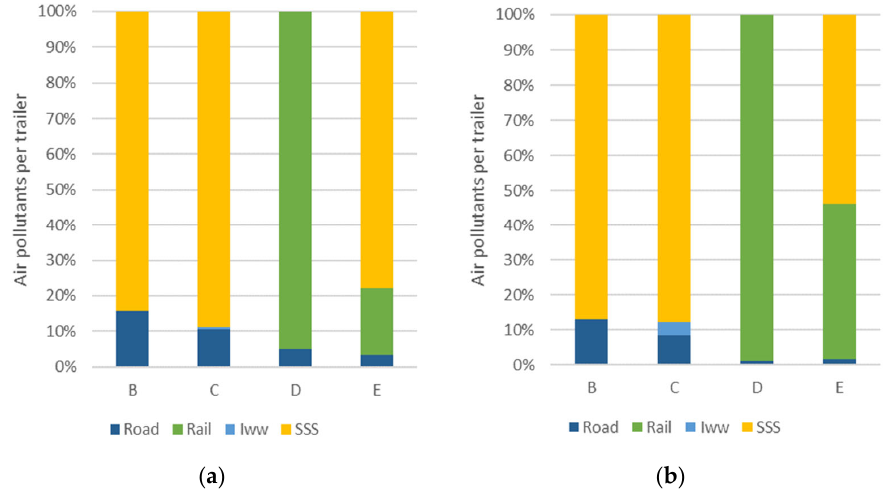
Figure 5. Share of NO x , SO 2 , and PM emissions per transport mode: ( a ) scenario 1; ( b ) scenario 2.